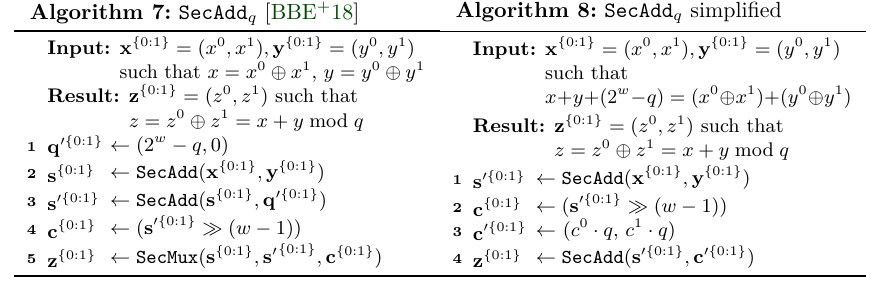
Algorithm 7: SecAdd q [BBE + 18] Algorithm 8: SecAdd q simplified